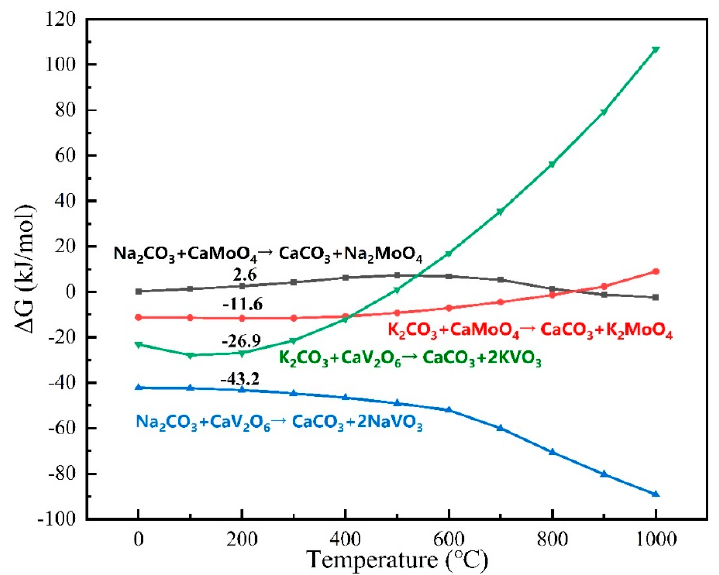
Figure 4. Δ G − T plots of the reactions of K 2 CO 3 and Na 2 CO 3 with CaV 2 O 6 and CaMoO 4 .